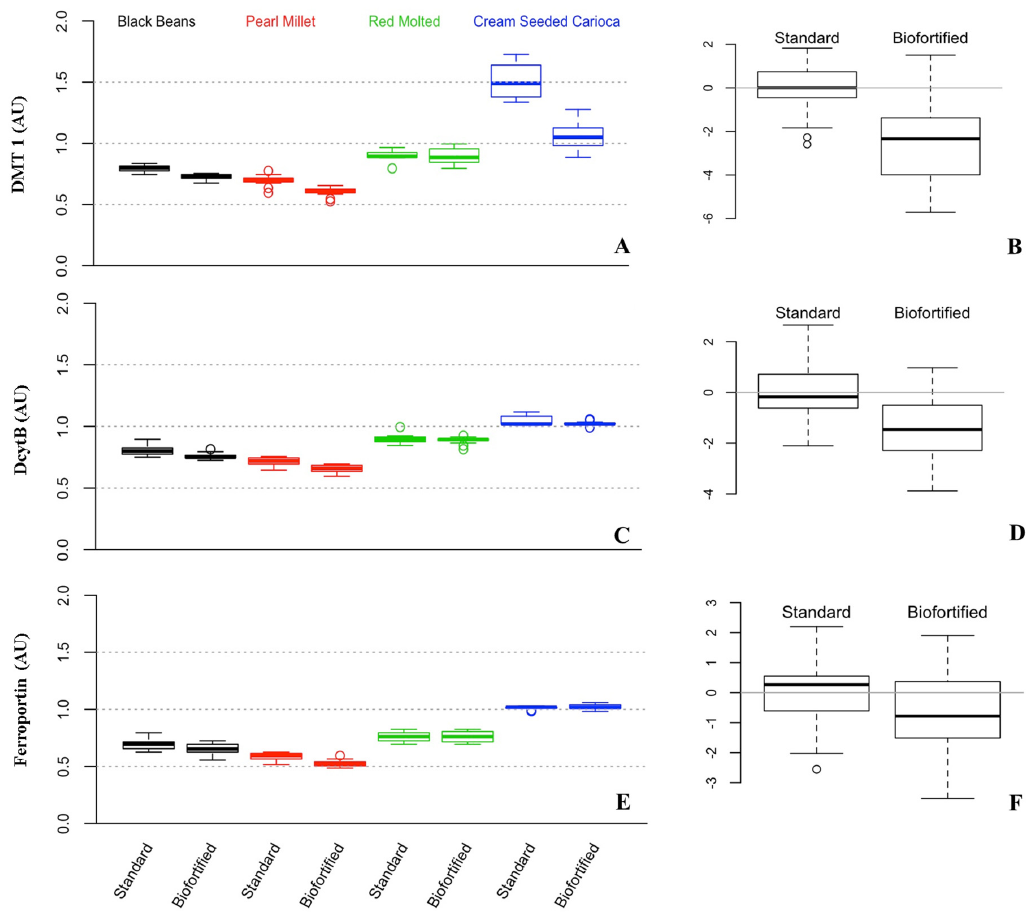
Figure 4. Duodenal mRNA expression of DMT1, DcytB and Ferroportin. Changes in mRNA are shown in relative expression of 18S rRNA in arbitrary units (mean ± SEM, AU, p < 0.05). ( A , C , E ) Experimental treatment differences; ( B , D , F ) overall standardized and cross experimental standard vs. biofortified treatment groups.